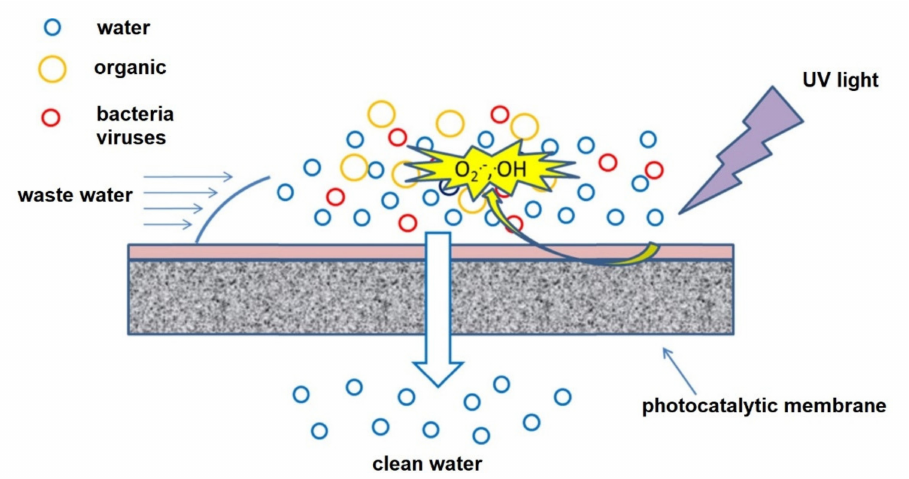
Figure 4. Schematic illustration of how a photocatalytic membrane operates with the photocatalytic layer on top degrading pollutants and membrane filtering the remaining pollutants. Reprinted from [50] with permission from